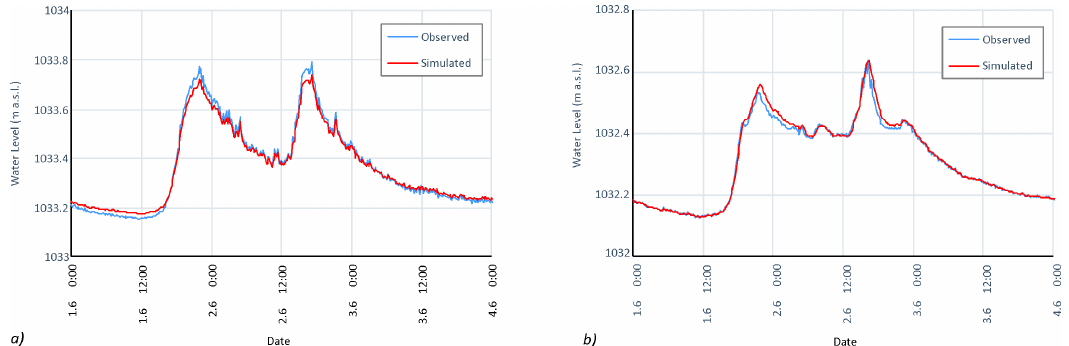
Figure 7. Hydrodynamic model validation of the case of flood in June 2013 at the location of gauging stations with automated water level sensors. ( a ) Javo ř í brook; ( b ) Tmavý brook.